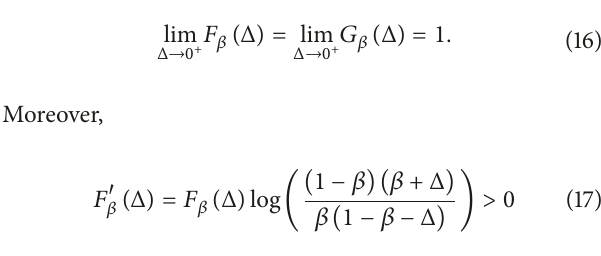
Figure 1: The bifurcation diagram of 𝑓 with respect to Δ ∈ (0,0.49] , for 𝑤 𝑥 = 1 , 𝑤 𝑦 = 1.5 , 𝑎(0) = 0.85